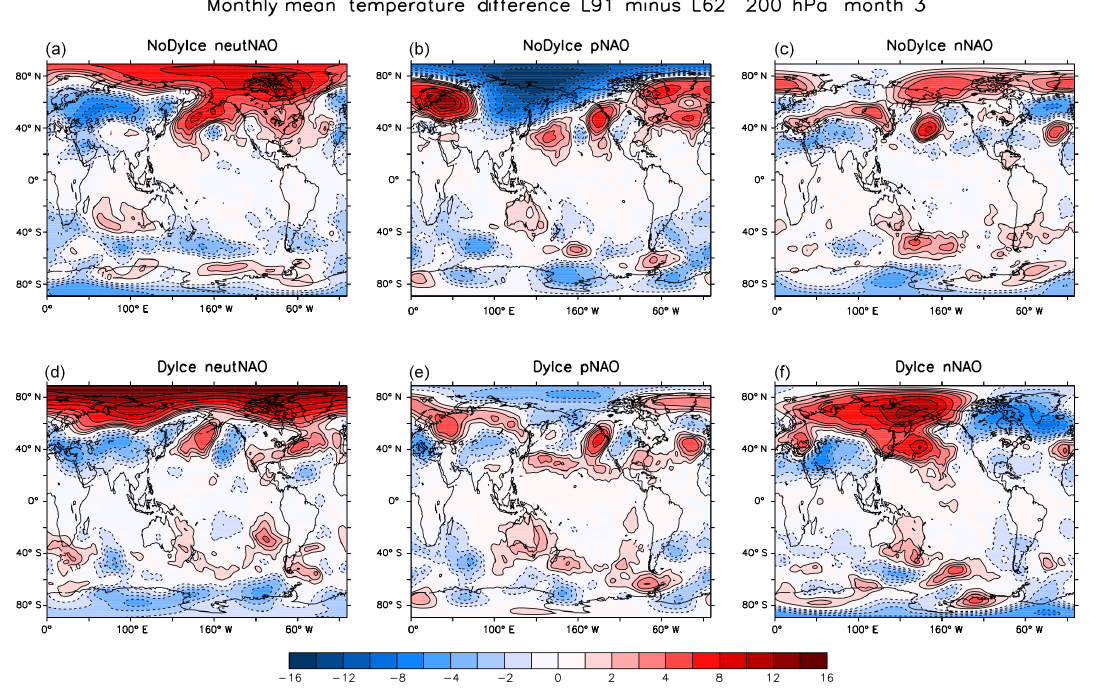
Figure 1. Map of monthly mean air temperature difference at 200hPa between the high-top and low-top experiments for month